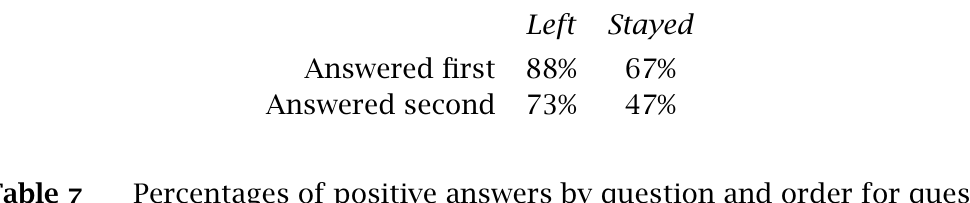
Percentages of positive answers by question and order for ques- tions (i) and